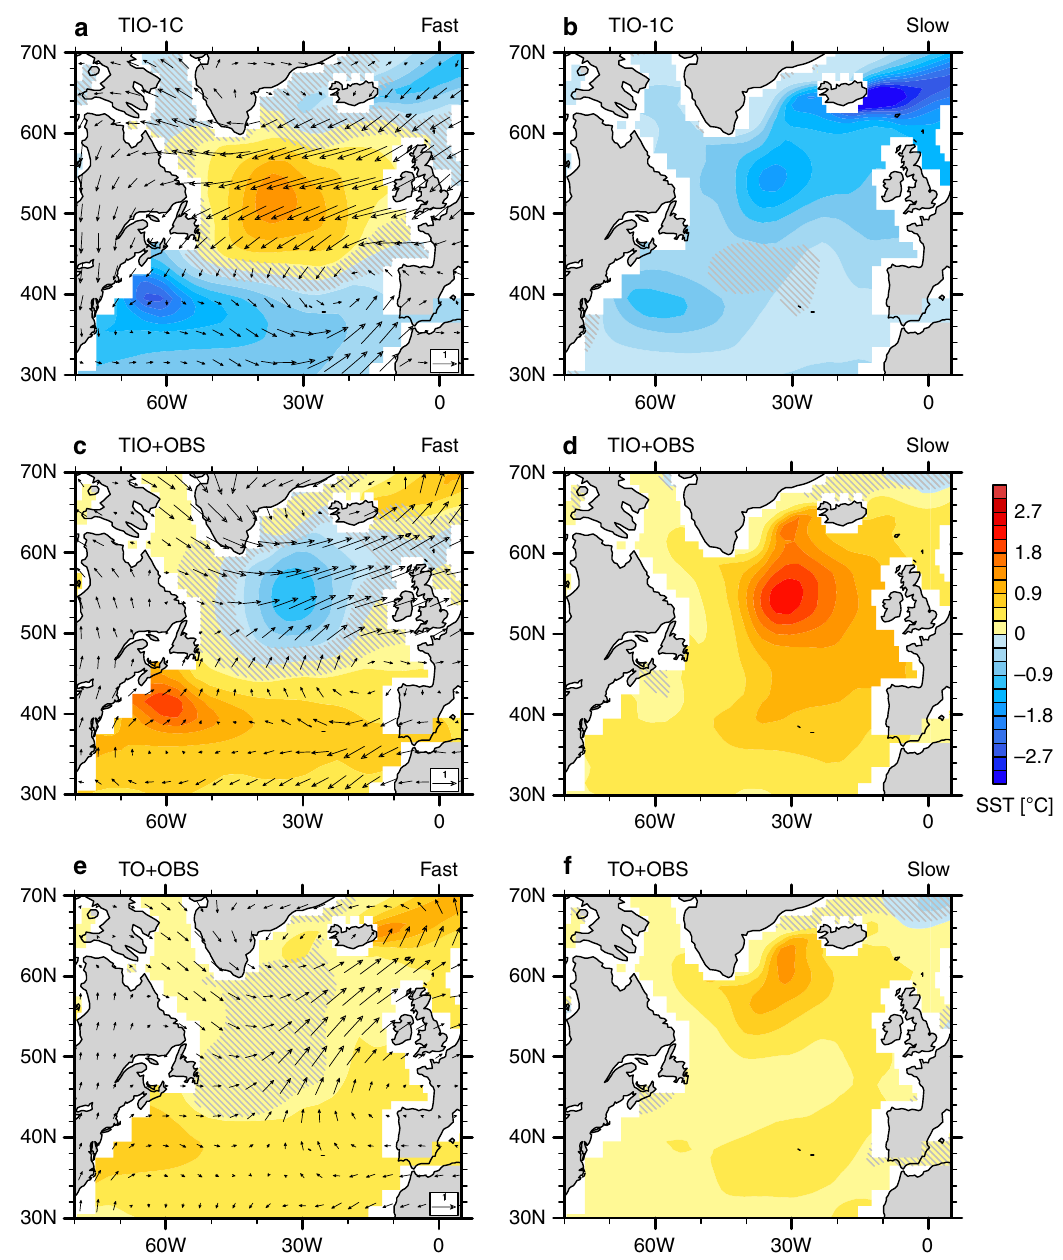
Fig. 8 The fast and slow responses of the North Atlantic climate to tropical Indian Ocean (TIO) warming in different sensitivity experiments. a , b Anomalies in sea surface temperature (SST; units: °C) and surface winds (units: m s − 1 ) for the TIO-1C experiment with respect to the pre-industrial (PI) experiment; panel a is for fast response averaged over Years 1 – 40 (cf. Fig. 6a) and panel b is for slow response de fi ned as the difference between Years 151 – 200 and Years 1 – 40 (cf. Fig. 6c). c , d Same as panels ( a ) and ( b ) but for the TIO + OBS experiment. e , f Same as panels ( a ) and ( b ) but for the TO + OBS experiment. See “ Methods ” for the details of experimental set-up. Gray hatches highlight the areas of lower statistical signi fi cance ( p -values of Student ’ s t test above